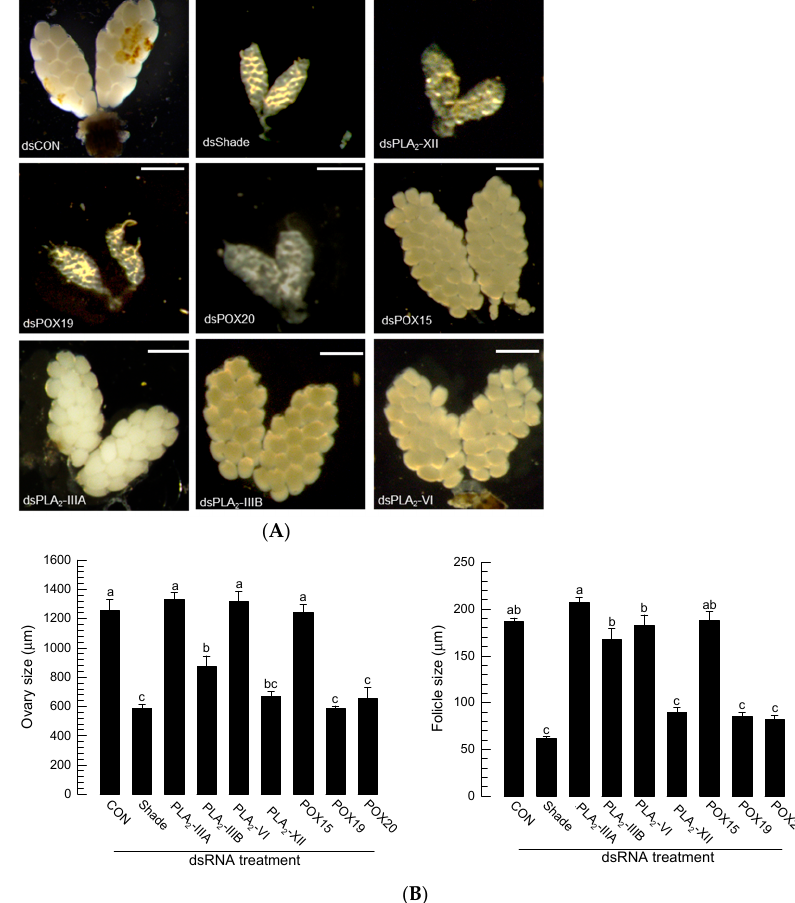
Figure 7. Functional association of PG biosynthesis-associated genes on the ovary development in Ae. albopictus . ( A ) Effect of individual RNAi on ovary development. The RNAi treatments were specifically targeted against Aa-Shade , Aa-PLA 2 -XII , Aa-PLA 2 -IIIA , Aa-PLA 2 -IIIB , Aa-PLA 2 -VI , Aa-POX19 , Aa-POX20 , or Aa-POX15 . dsRNA (300 ng/adult) was injected into 4-day-old female mosquitoes before 24 h blood feeding (‘BF’). At 48 h after BF, the ovary development was assessed. Each scale bar indicates 400 µm. A GFP gene was used as a control dsRNA (‘dsCON’). ( B ) Comparison of ovary and its follicle developments among RNAi treatments. Each treatment was replicated three times, with three randomly chosen mosquitoes. The different letters above the standard error bars indicate significant differences among means at Type I error = 0.05 (LSD test).